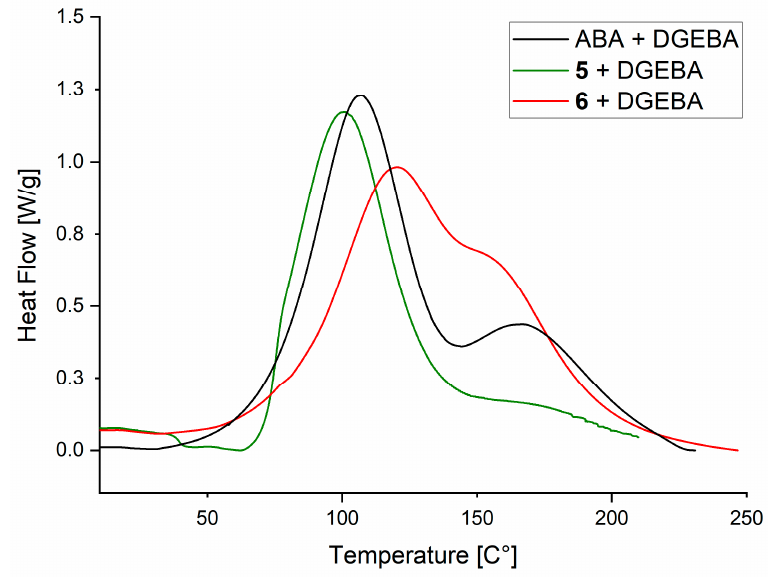
Figure 4. DSC thermograms of hardeners 1 , 2 , and ABA during curing with DGEBA.